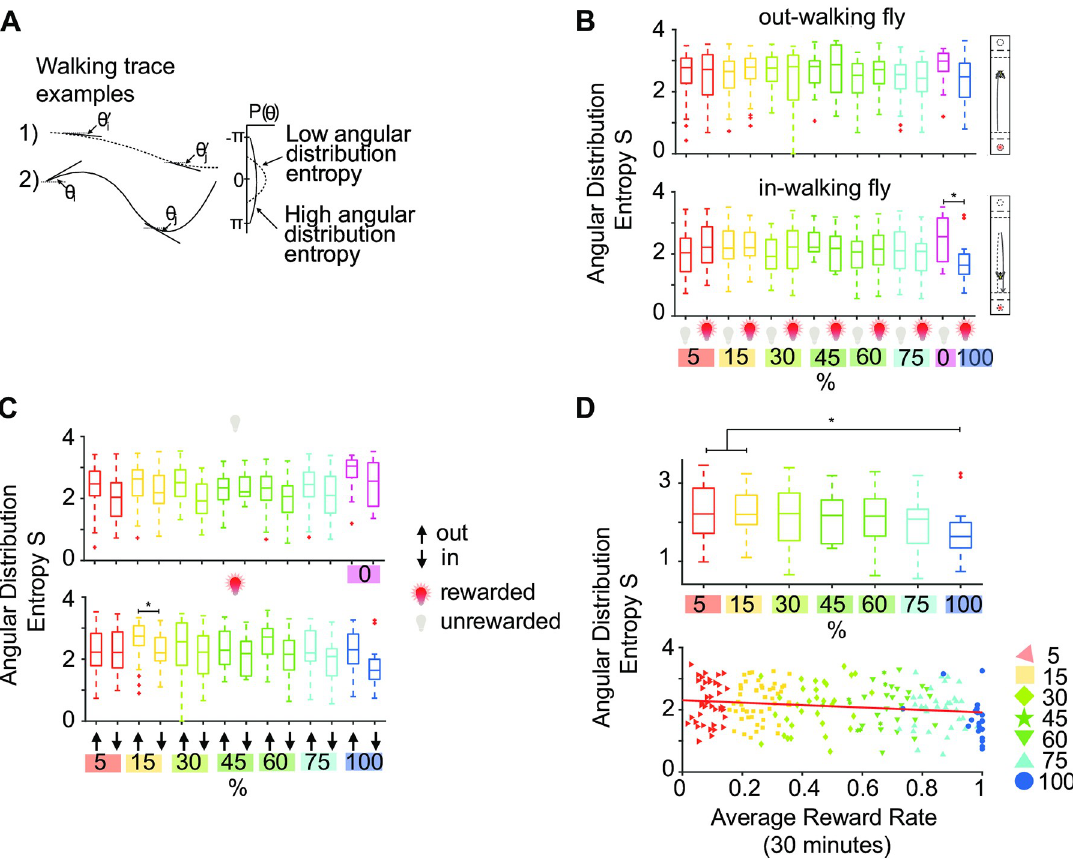
Fig 5. The accumulated value affects walking direction of flies. A Sketch of path angular distribution analysis. The “straighter” path 1) is characterized by a narrow angular distribution, while the more curved path 2) has a broader angular distribution. If the distribution is narrowly peaked, it has a smaller entropy S than a broader distribution. B Angular distribution entropy of in- and out-walking paths (box plots with median and quartiles shown), on rewarded (red light bulb) and unrewarded (grey light bulb) trials. For out-walking (away from the rewarded zone, measured from the reset zone) trajectories, there is no difference between rewarded and unrewarded trials. For in-walking trajectories (from the position of return to the reset zone), the rewarded trials have a smaller entropy, corresponding to more straight paths. This is significant for 100% compared to unstimulated controls ( � : p < 0.05, Kruskal-Wallis test with multiple comparisons). C Same data (box plots with median and quartiles) as in B but sorted by unrewarded (top) and rewarded (bottom) trials. ( � : p < 0.05, Kruskal-Wallis test with multiple comparisons). D There is a trend of more straight in-walking after a reward (indication of path integration) with increased reward probability. Top figure: only rewarded trials from B bottom ( � : p < 0.05, Kruskal-Wallis test with multiple comparisons). Bottom figure: Same data plotted against each fly’s experienced average reward rate. Red line: Pearson correlation, R = -0.18, p = 0.005 (Robust Correlation package by [32]).